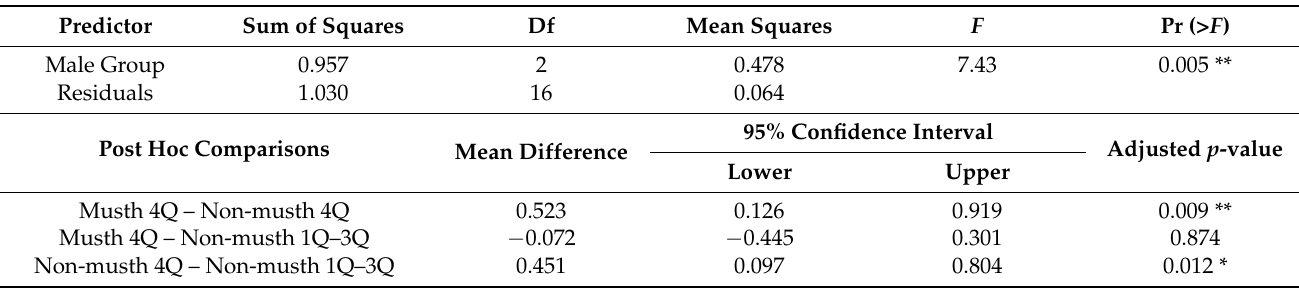
Table 3. One-way ANOVA results for the behavioral responses of male African elephants ( n = 19) subjected to estrous call playbacks in 2008. Pairwise comparisons across three male groups (non- musth 1Q–3Q, non-musth 4Q, and musth 4Q) were conducted using a Tukey’s HSD post hoc test (95% CI) to evaluate between-group differences in behavioral response.